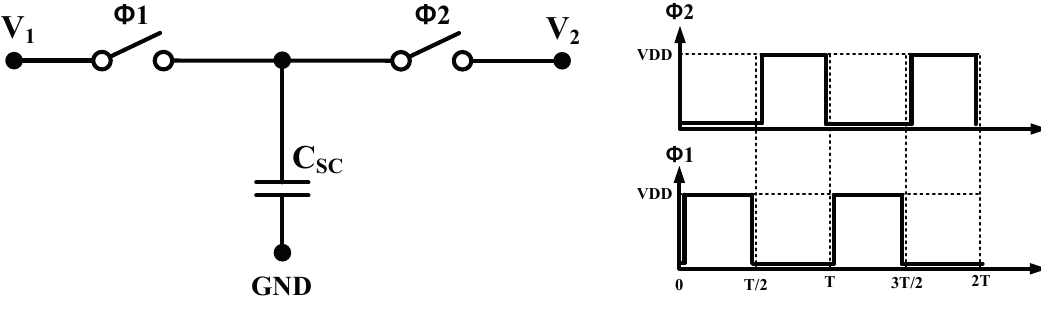
Figure 5. Schematic and timing diagram of the SC resistor